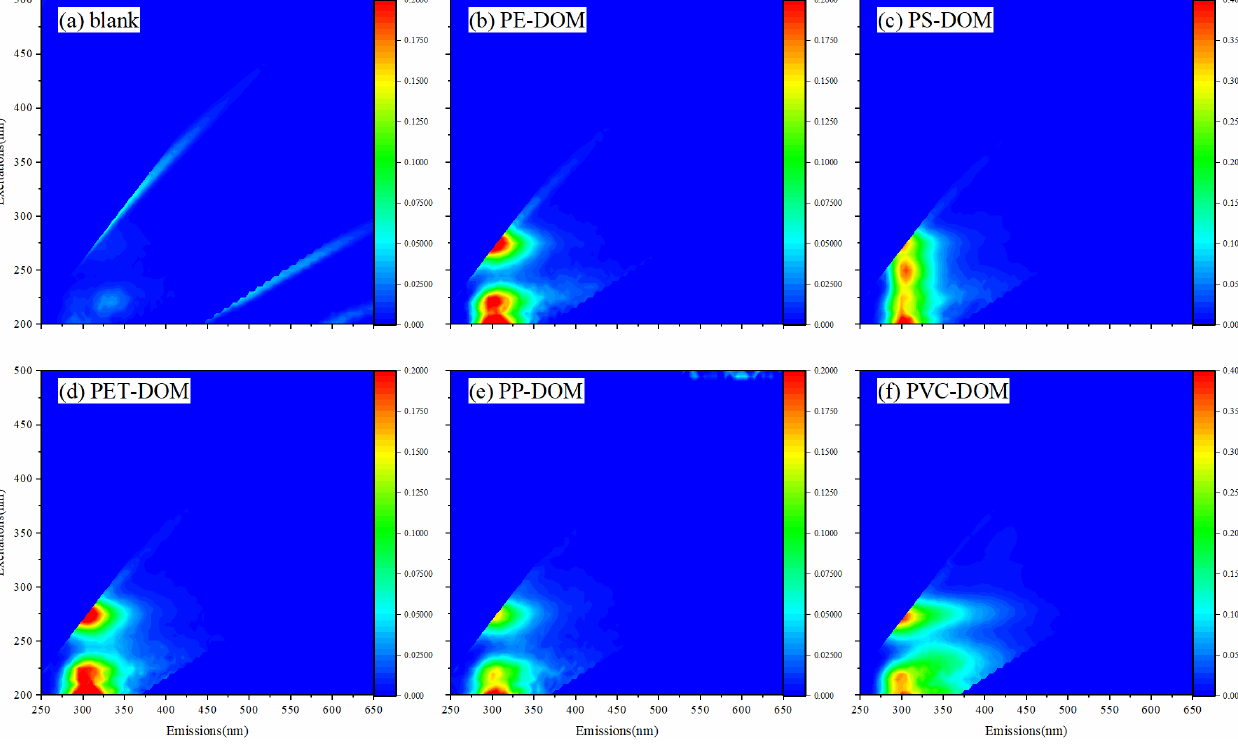
Figure 2. Fluorescence EEM plots of ( a ) artificial freshwater solutions used as a background, and the DOM leached from ( b ) PE; ( c ) PS; ( d ) PET; ( e ) PP; and ( f ) PVC after 7 days of leaching (5 g L −1 ). Note that different scales were used for different plastics due to their varying signal ranges.